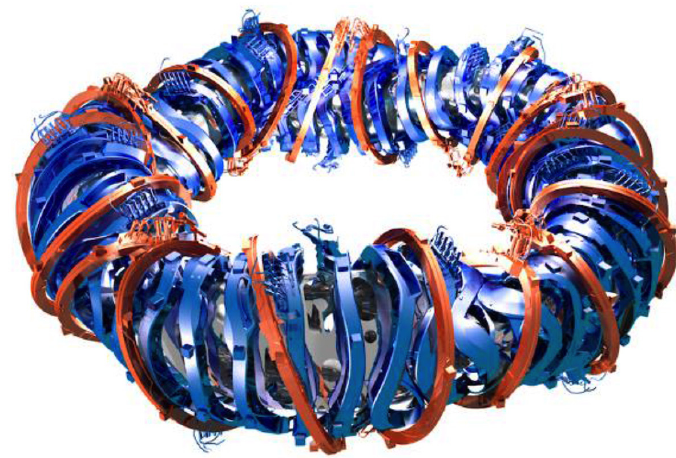
Fig. 9. – An illustration of the complex shapes of the coils of a modern stellarator, which combine the functions of the separate coil systems of fig.